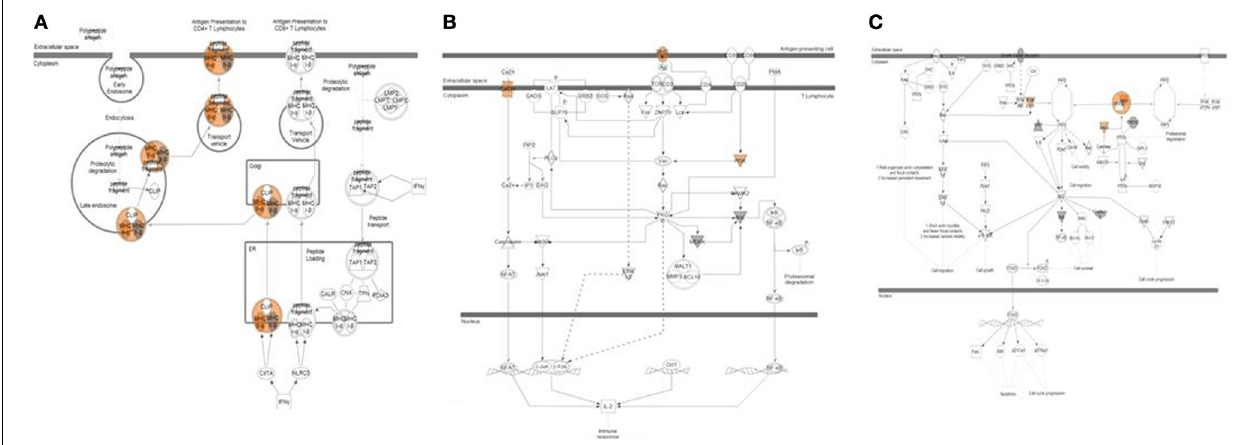
were mapped predominantly to one branch of pathway related to activation of CD4 + Lymphocytes. (B) PKC-Theta Signaling in T-Lymphocytes affected in 14 relapse cases shown. (C) PTEN Signaling affected in 14 relapse cases